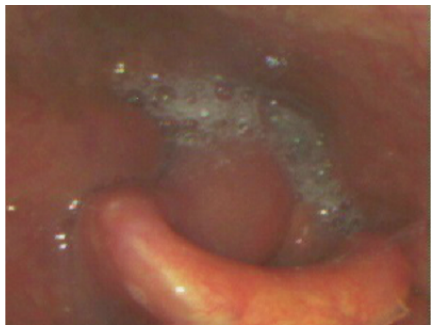
Figure 1: Bilateral intense arytenoid edema with fullness of the right pyriform sinus.